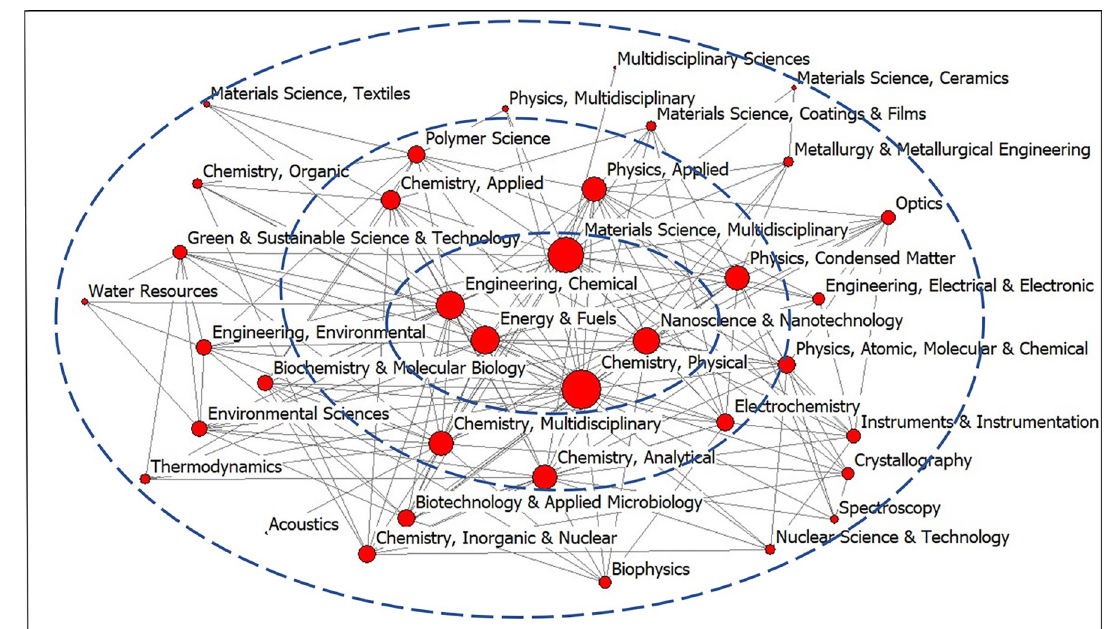
Fig 3. The disciplinary interactive network in the period of